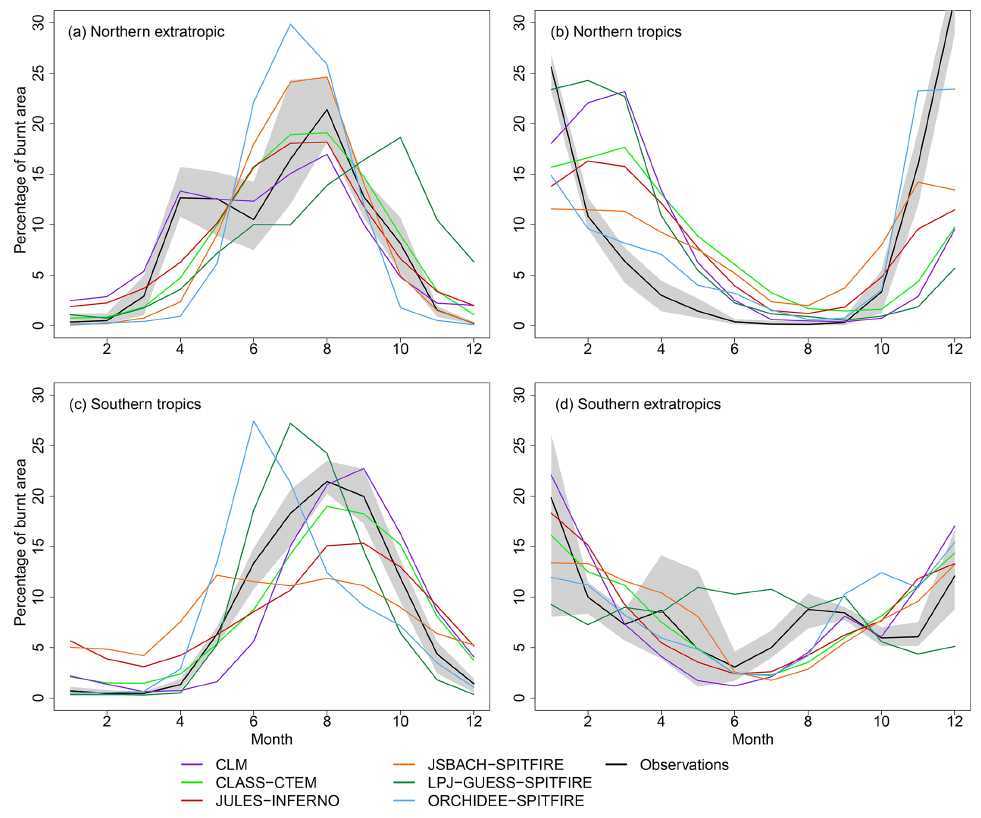
Figure 3. Simulated and observed seasonality (2002–2012) of burnt area (% of annual burnt area per month) for (a) northern extratropics ( > 30 ◦ N), (b) northern tropics (0–30 ◦ N), (c) southern tropics (0–30 ◦ S) and (d) southern extratropics ( > 30 ◦ S). The mean of all the remotely sensed burnt area datasets is shown as a black line, with the minimum and maximum range shown in light grey.